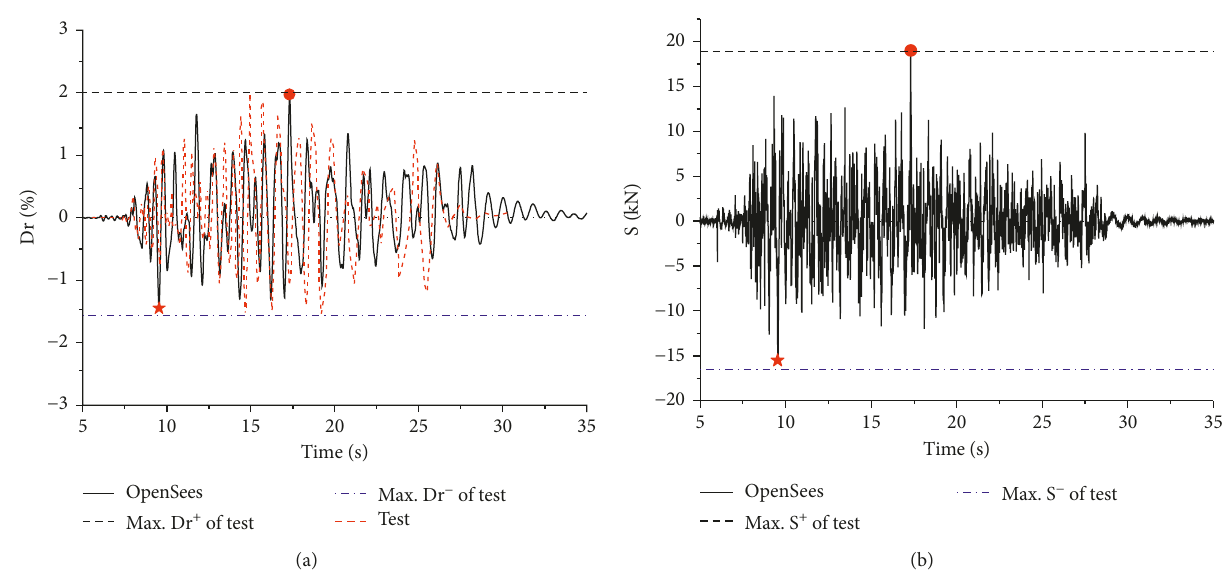
Figure 5: Comparison of analytic model and test for specimen ST 1-a. (a) Drift ratio. (b)